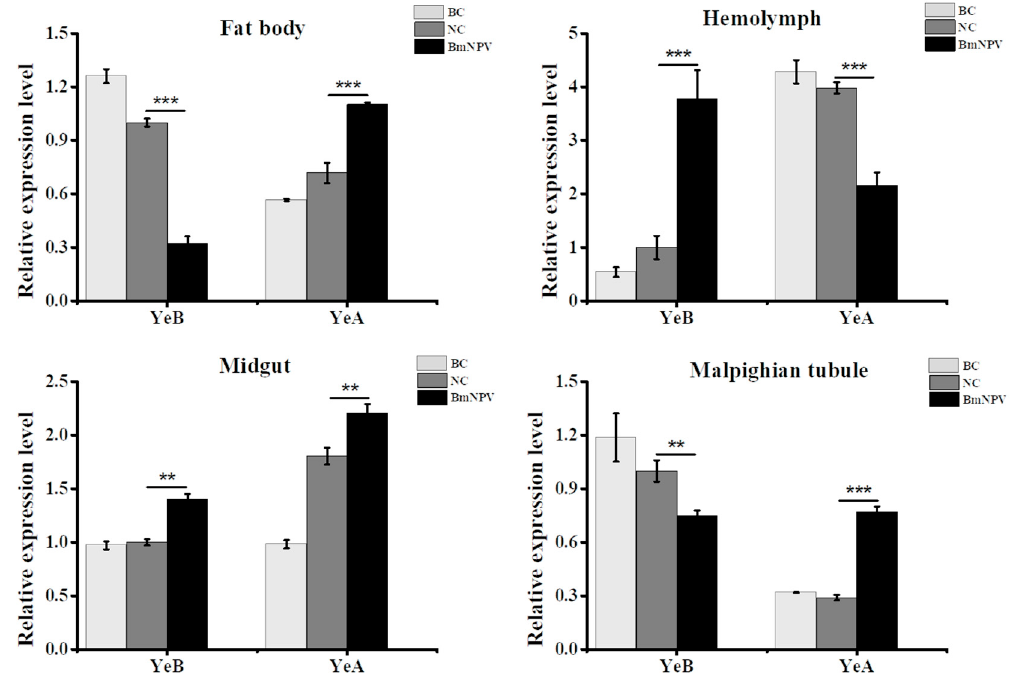
Figure 2. The analysis of Bmapaf-1 expression level in different tissues of different resistant strains following BmNPV infection using RT-qPCR. YeA was a resistant silkworm strain, and YeB was a susceptible silkworm strain. BC, blank control; NC, negative control. BmGAPDH was used to normalize the data that were shown as the mean ± standard error, and the mean was from three independent repeats. The 2 − △△ Ct method was adopted to calculate the relative expression level. Differences among triple repeats were analyzed using the SPSS Statistics 20 software (IBM, USA) with the one-way ANOVA method. Asterisks represented the significant difference, as follows: ** p < 0.01; *** p < 0.001.